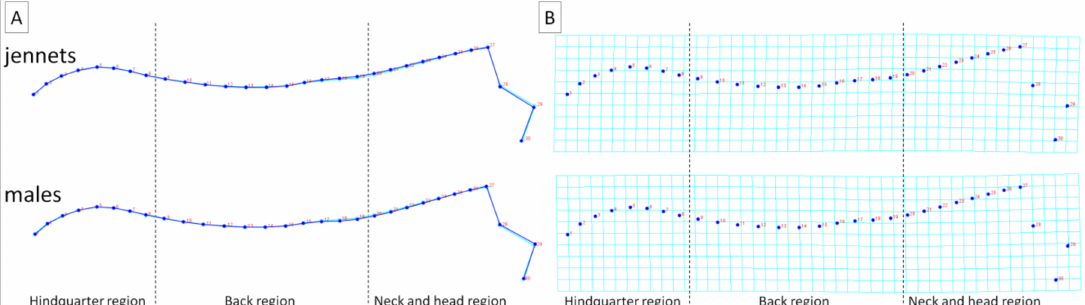
Figure 8. Average observations of the donkeys’ dorsal profiles grouped by sex (jennets; males) and represented by